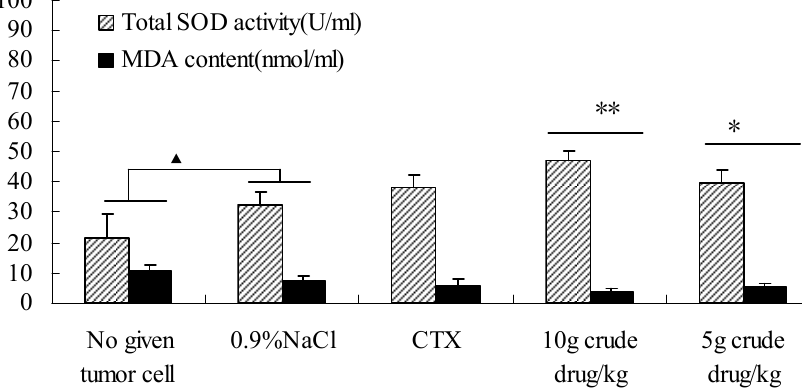
The SOD activity and MDA content in serum of tumor-bearing mice. ▲ indicates a significant difference between the 0.9%NaCl group and the no given tumor cell group ( ▲ p ≤ 0.05). ** p ≤ 0.01, 10 g crude drug/kg P-60 group vs. 0.9% NaCl group, CTX and no given tumor cell group; * p ≤ 0.05, 5 g crude drug/kg P-60 group vs. 0.9% NaCl group, CTX and no given tumor cell group. The data was expressed as mean ±SD (n = 8 in each